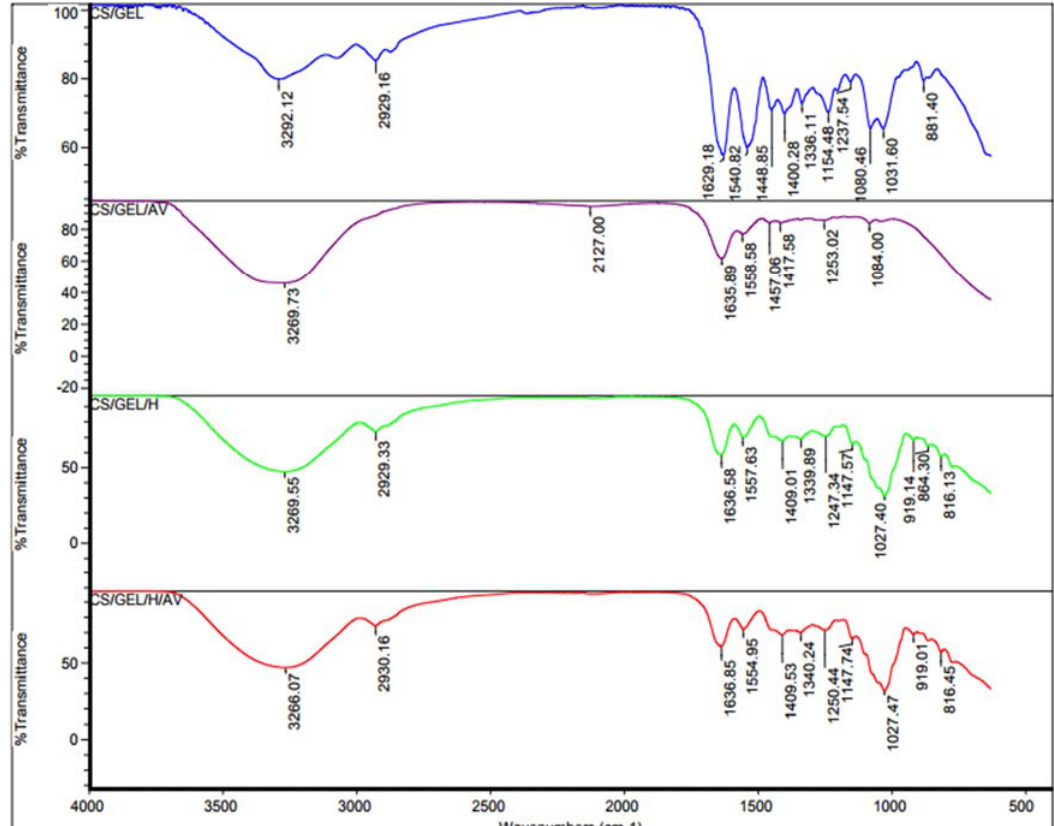
Fig. 4. ATR-FTIR spectrum of composite thin